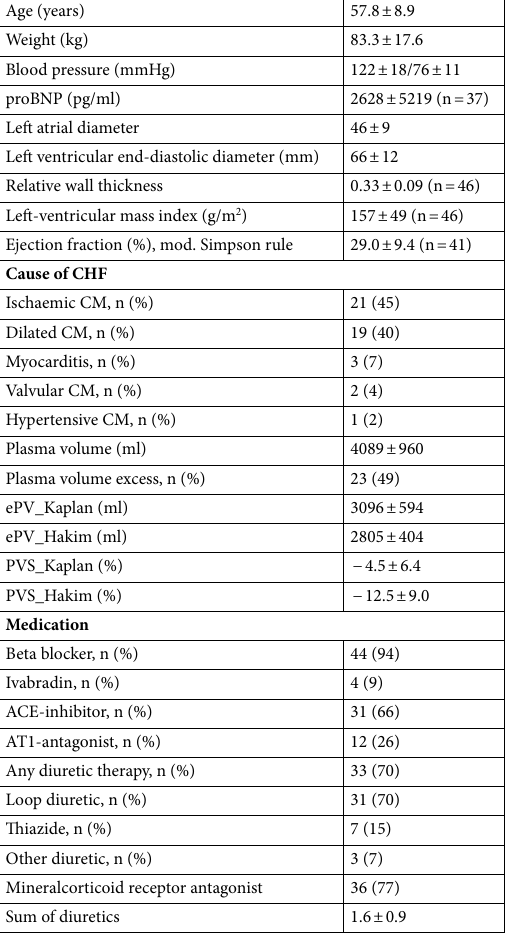
Table 1. Baseline characteristics (n = 47) as in part previously published 17